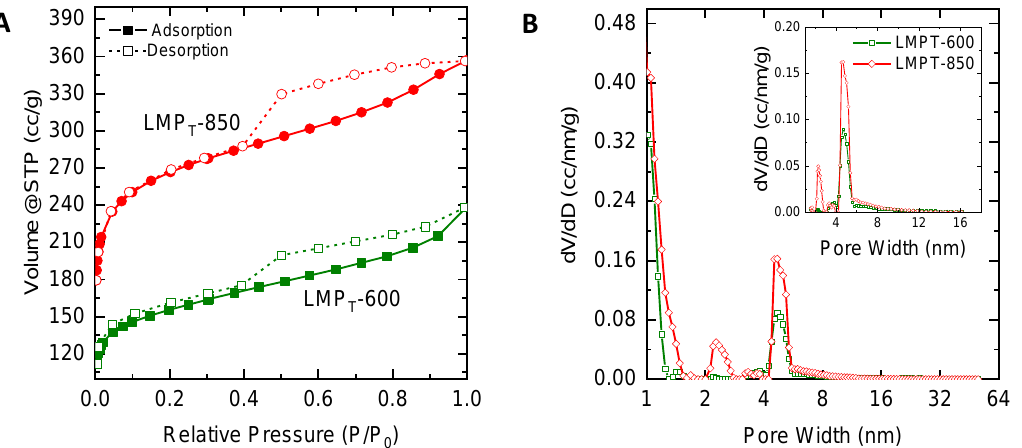
Figure 5. ( A ) Adsorption and desorption of nitrogen in carbon mangosteen peel lignin extracted using organosolv at 150 °C; ( B ) QSDFT-N 2 pore size distribution of carbon mangosteen peel lignin extracted by using organosolv at 150 °C.